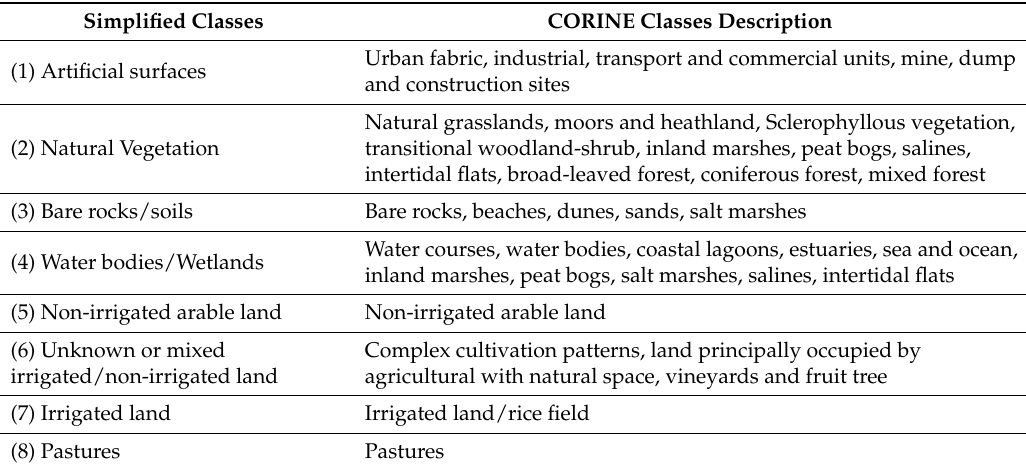
Table 5. Simplified CORINE land cover classes.